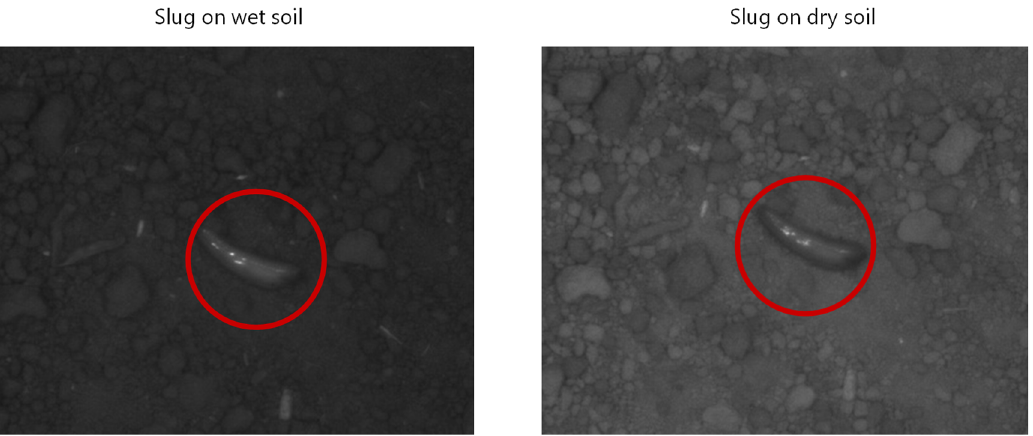
Figure 6. Comparison of soil vs. A. vulgaris ( left ) and soil vs. D. reticulatum ( right ). In addition to the variety of slug, the soil condition had an impact on the appearance of the slug on the soil in an image. In Figure 7, two 925 nm narrow bandpass-filtered images of the same individual of D. reticulatum on the same soil are shown. In the left image, the slug was positioned on wet soil. On the right image, the slug was positioned on dry soil. In the left image, the slug appears bright; in the right image, the slug appears dark.